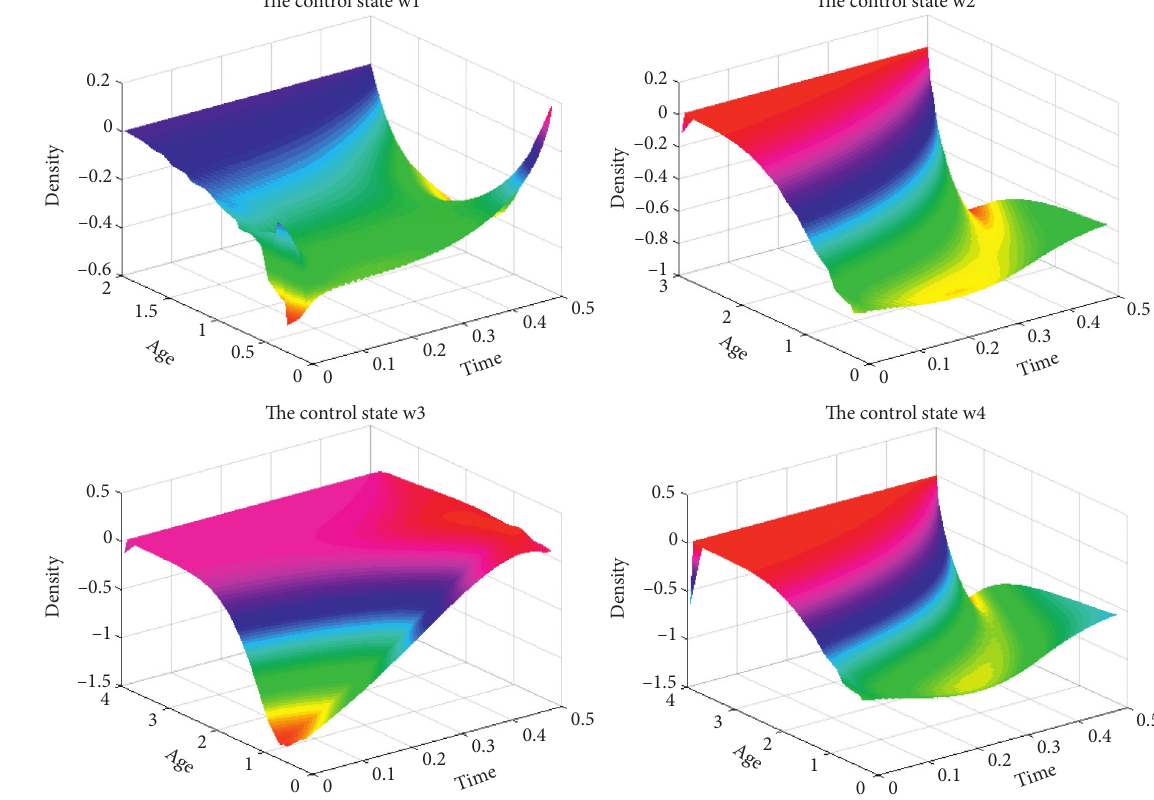
Figure 3: Control state at final time T � 0 . 5 and A �